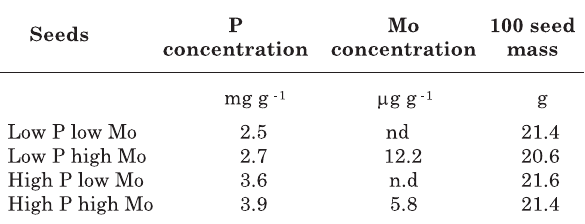
Table 1. Concentration of P and Mo, and 100-seed mass, of common bean seeds of the Carioca cultivar tested in the